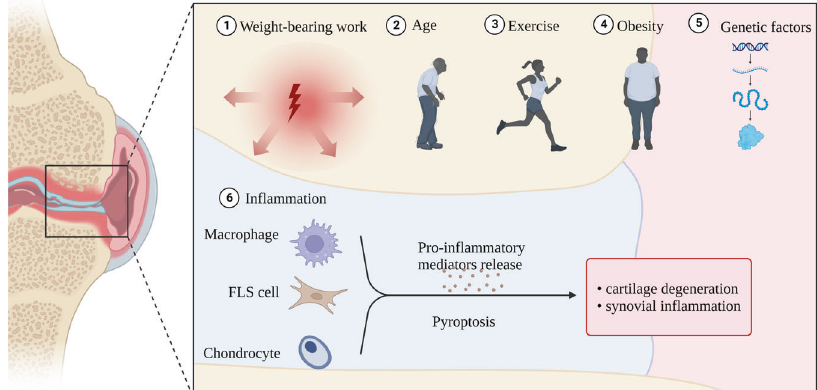
Fig. 7 Pyroptosis and OA: Etiologies of OA include age, in fl ammation, obesity, weight-bearing work, exercise, and genetic factors. Among in fl ammatory factors, pyroptosis of macrophages, FLS cells, and chondrocytes plays an important